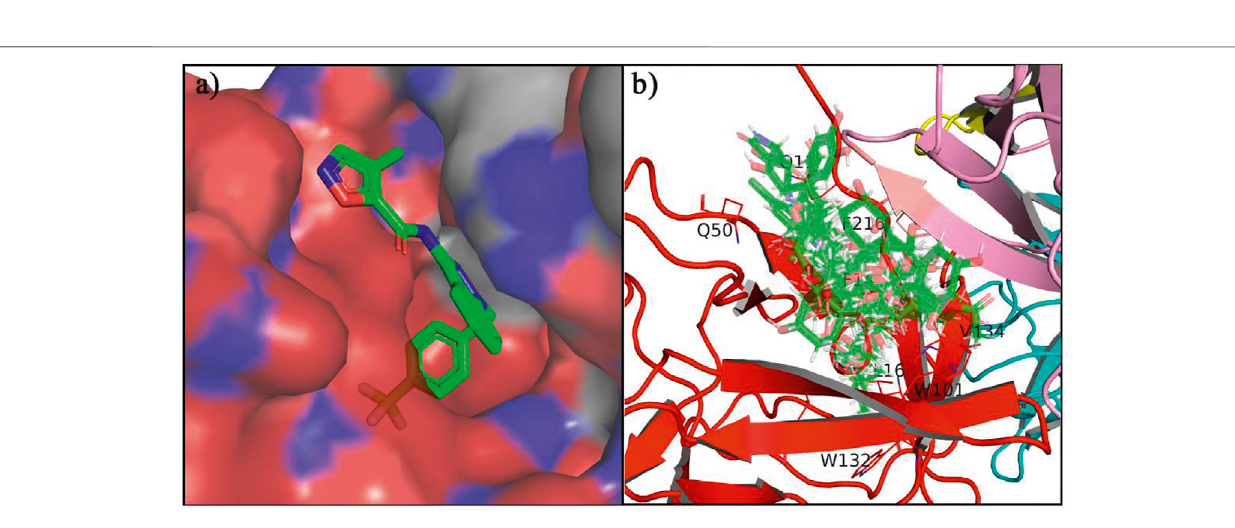
Frontiers in Chemistry |